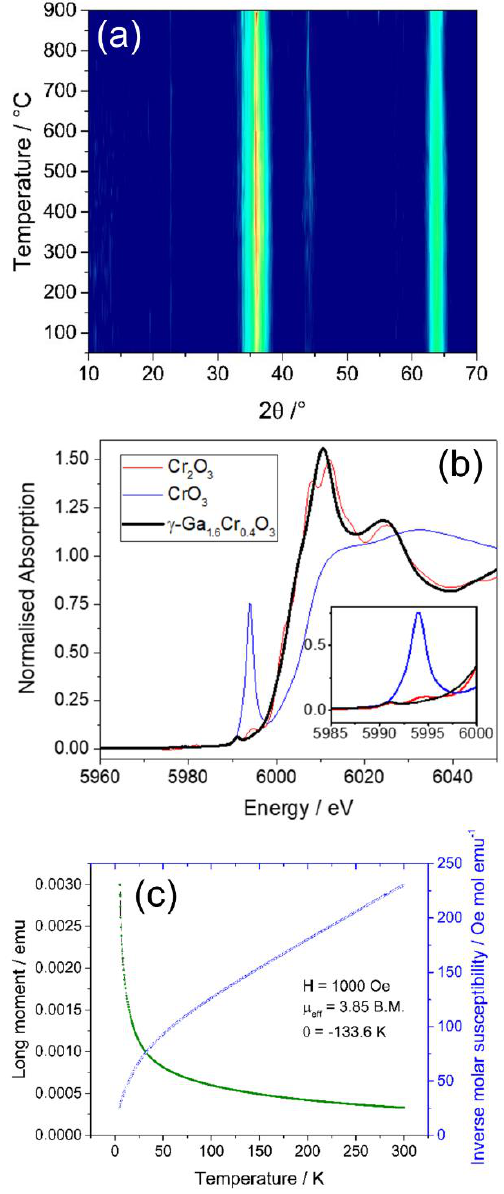
Figure 2. ( a ) In situ thermodiffractometry of γ -Ga 1.4 Cr 0.6 O 3 showing lack of structure collapse to 900 ◦ C; ( b ) Cr K-edge X-ray absorption near-edge spectroscopy (XANES) spectra of γ -Ga 1.4 Cr 0.6 O 3 and two crystalline standards with (inset) showing the lack of a pre-edge feature in the spinel; ( c ) field cooled (FC) magnetometry of γ -Ga 1.4 Cr 0.6 O 3 (green) showing simple paramagnetic behaviour, and inverse susceptibility (blue).